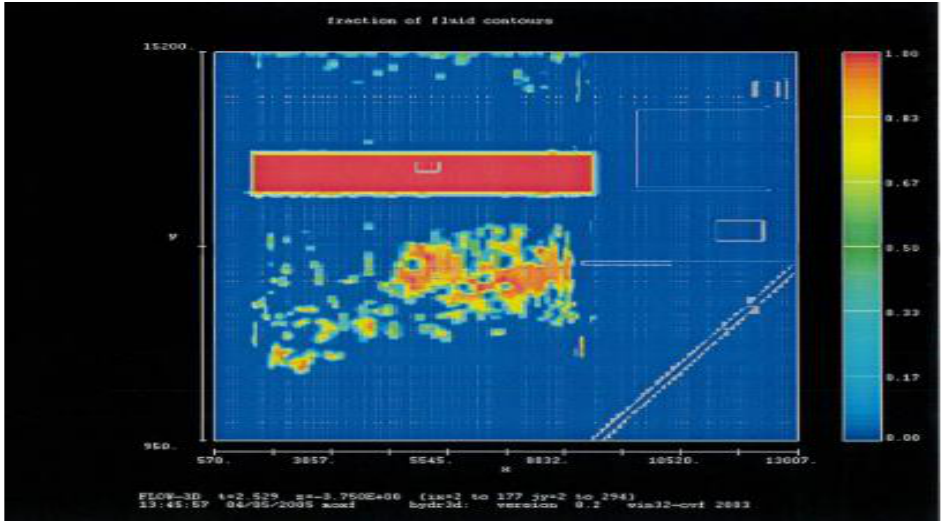
Figure 18. Aquifer fluid fraction (ff) concentration at 3.75 m below the southern farm area surface 2.53 months after the extended drought ends. Color version added to [1], p. 367.